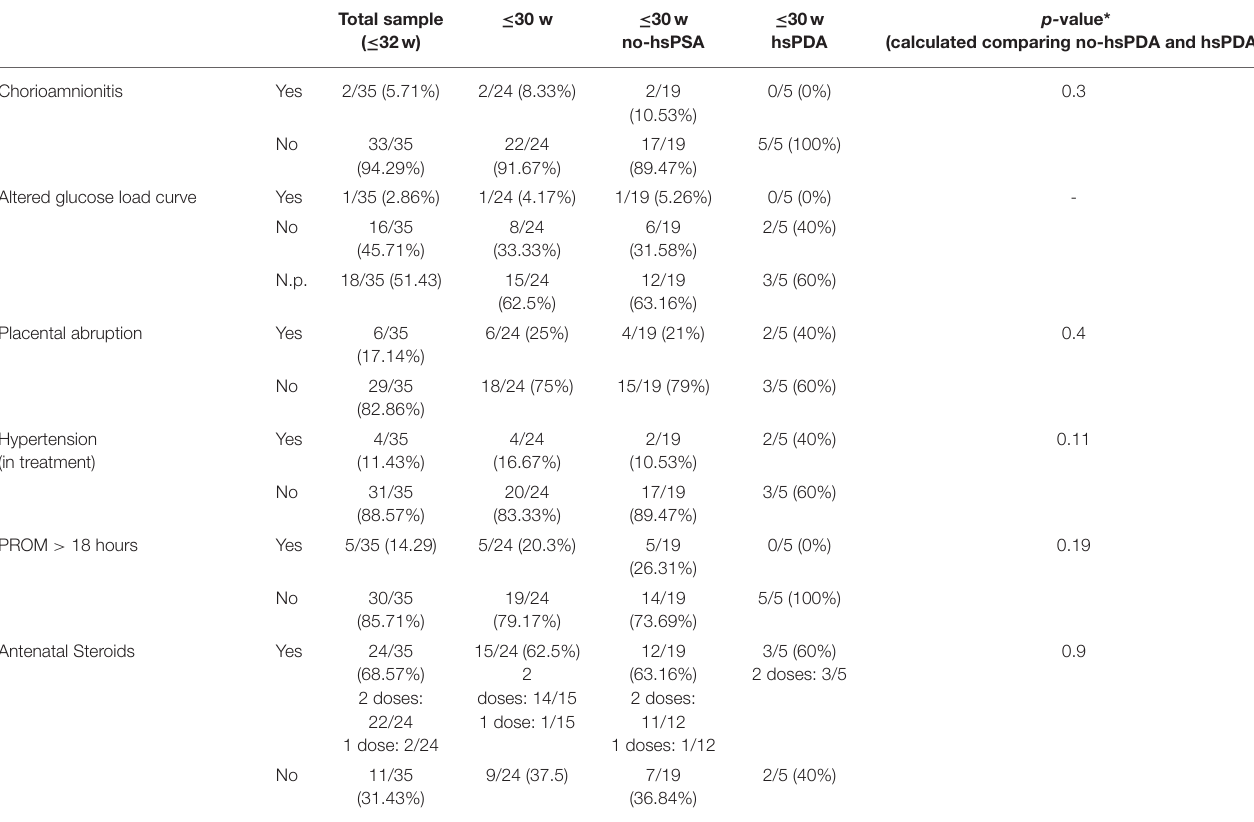
≤ 30 w ≤ 30w ≤ 30w p- value* Total sample ( ≤ 32w) no-hsPSA hsPDA (calculated comparing no-hsPDA and hsPDA)